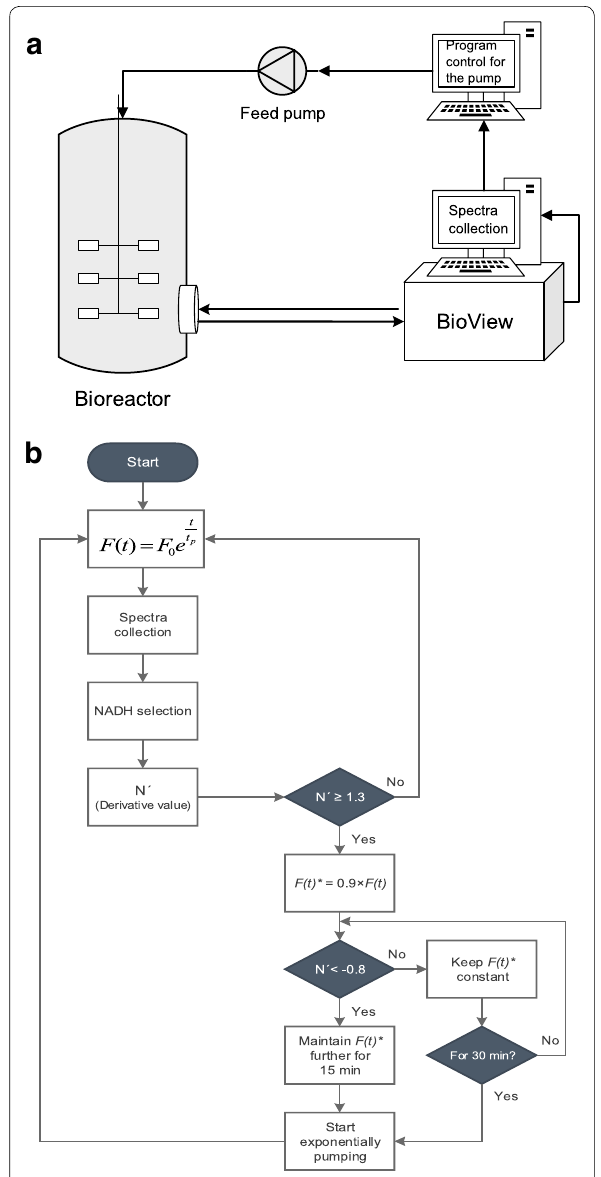
Fig. 1 a Schematic overview of the bioprocess setup of the fed- batch cultivations with the feedback control. b Overview flowchart of the feed rate